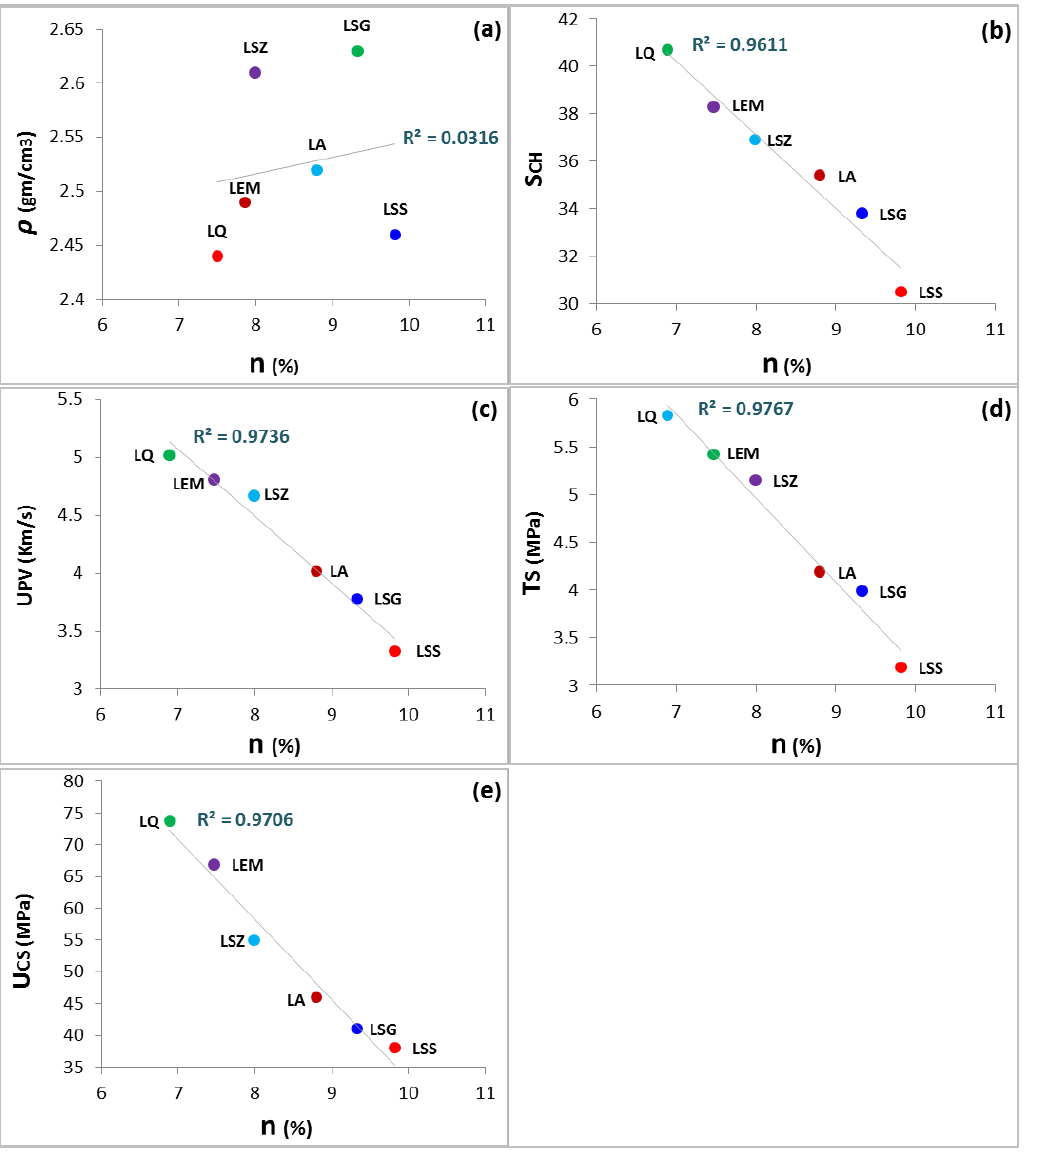
Figure 3. Relationship between porosity, n (%) and ( a ) desity, ρ (gm/cm 3 ), ( b ) Shmidt hammer rebound, S CH , ( c ) ultra sound pulse velocity, U PV (Km/s), ( d ) tensile strength, Ts (MPa), and ( e ) uniaxial compression strength, U CS (MPa).